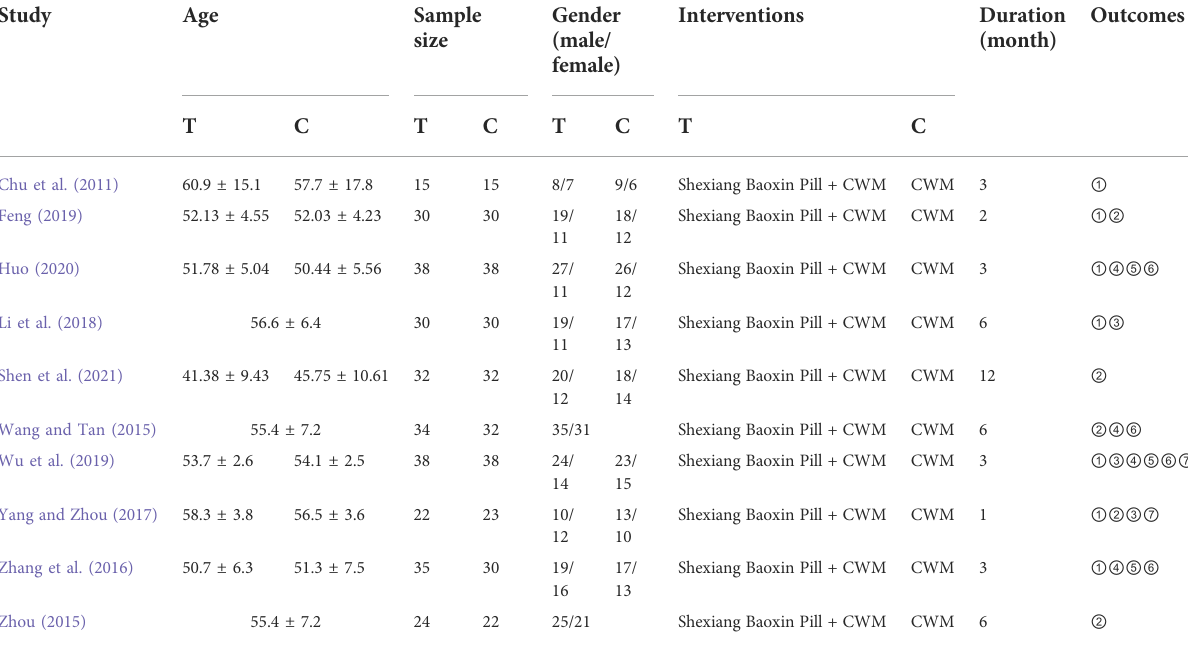
TABLE 1 Basic information of the included studies.